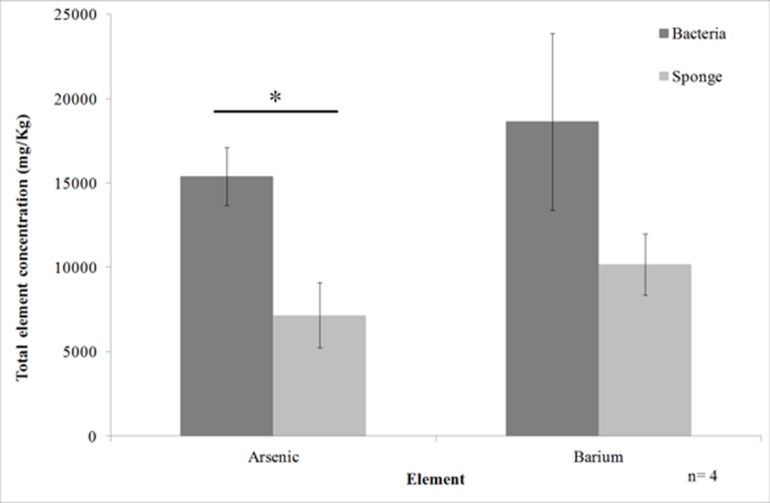
Arsenic and barium concentration in the cell enriched fractions of Theonella swinhoei (Mean ± SE). Line with asterisk above bars indicates significant difference in concentration between cellular fractions.